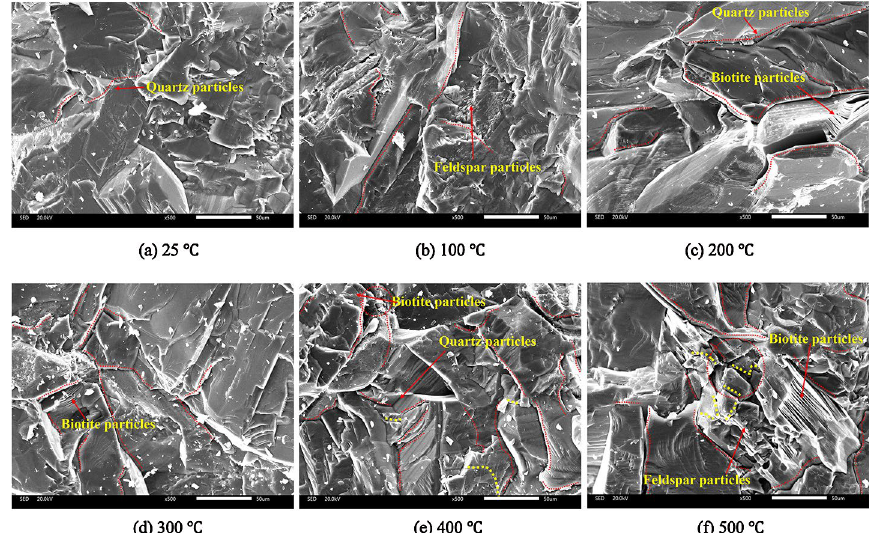
Fig. 10 SEM images of granite at 25–500 ℃ and 0.01 mm/min loading rate (The red lines indicate the intergranular cracks, the yellow lines indicate the transgranular cracks, and the red circles indicate the broken area.). a 25 ℃ . b 100 ℃ . c 200 ℃ . d 300 ℃ . e 400 ℃ . f 500